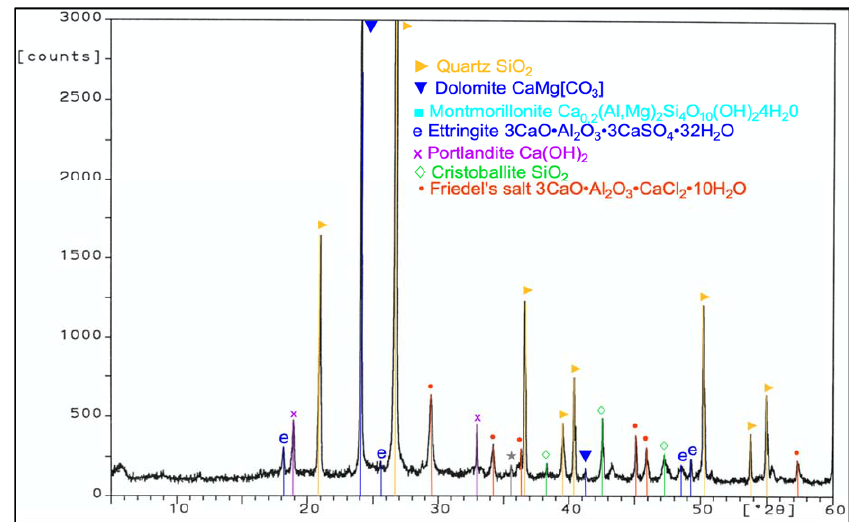
Materials 2021 , 14 , x FOR PEER REVIEW Figure 21. XRD pattern of the ZI mortar (100% CEM I) stored in 1% HCl for 365 days.